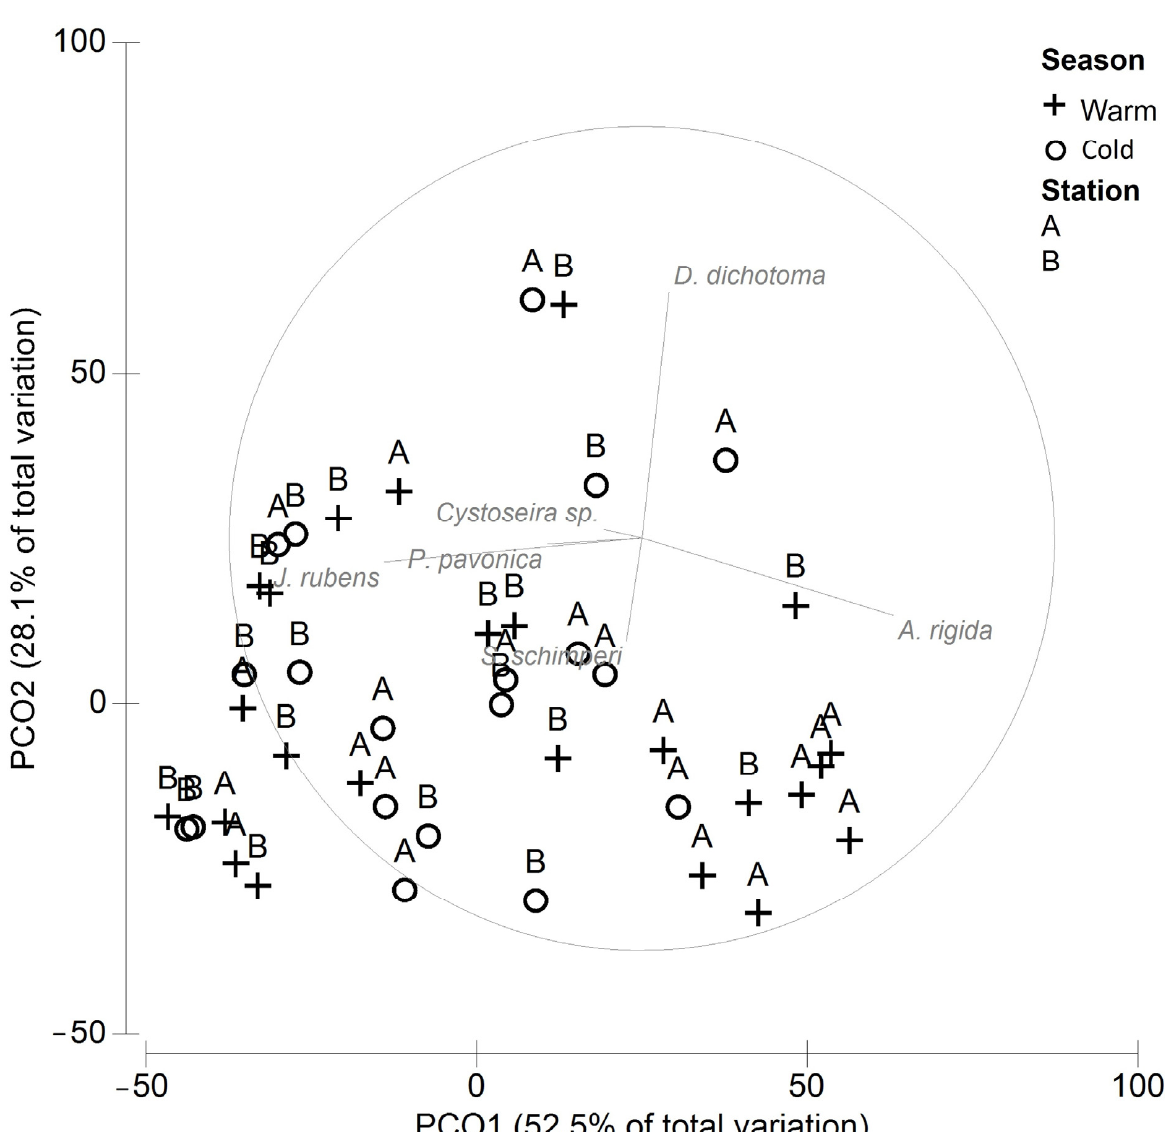
Figure 2. PCO of the macroalgae cover at stations A and B. The two ‐ way ANOVA on P. lividus density and biomass showed no significant Table 2. SIMPER results for macroalgae cover at each station, showing the species that contributed to the dissimilarity among differences between stations A and B; the only significant variation was found between seasons ( p ≤ 0.05). However, a significant variation was found in the condition index be ‐ tween the two stations, with the index being higher at station A ( p ≤ 0.05) (Table 3). Table 3. Average values of P. lividus biometric measurements for the two stations over the cold and warm periods. Values are (cid:1850) (cid:3365) ± SE ( n = 30). The significant differences ( p ≤ 0.05) between stations are represented by capital letters and between seasons by small letters.